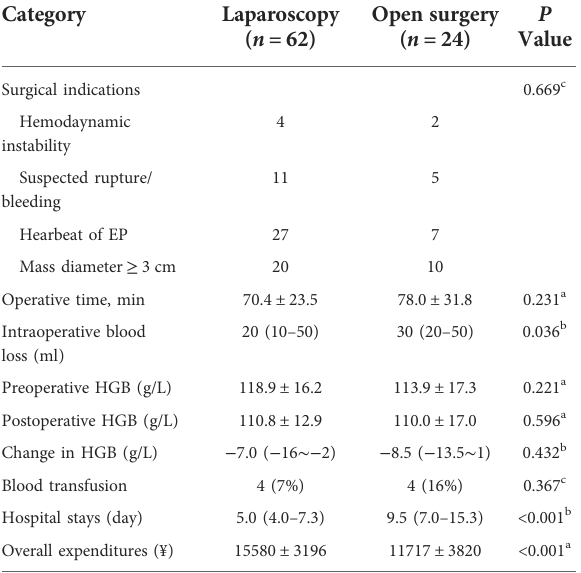
TABLE 2 Perioperative outcomes in laparoscopy and open surgery